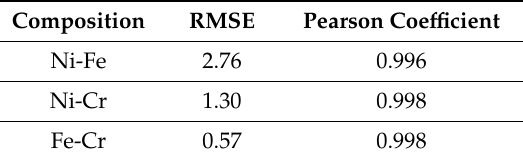
Table 2. Root mean square error (RMSE) and Pearson coefficient values of Ni-Fe, Ni-Cr, and Fe-Cr for 4320-atom supercells.